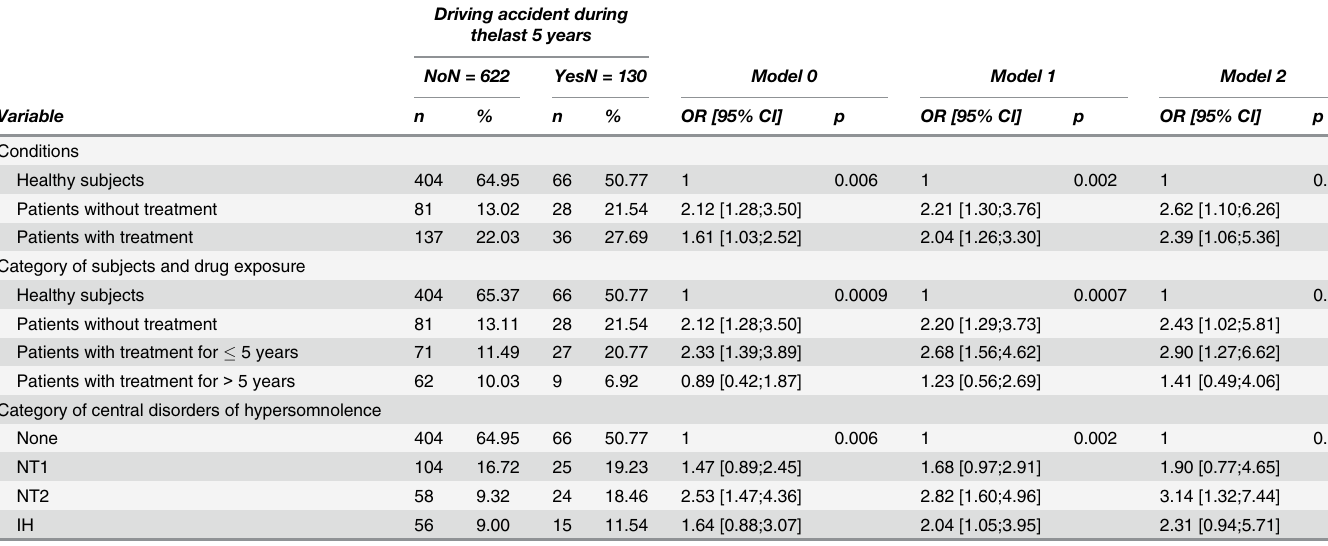
Table 3. Between-group (patients and healthy subjects) comparisons for the driving accident during the last 5 years.